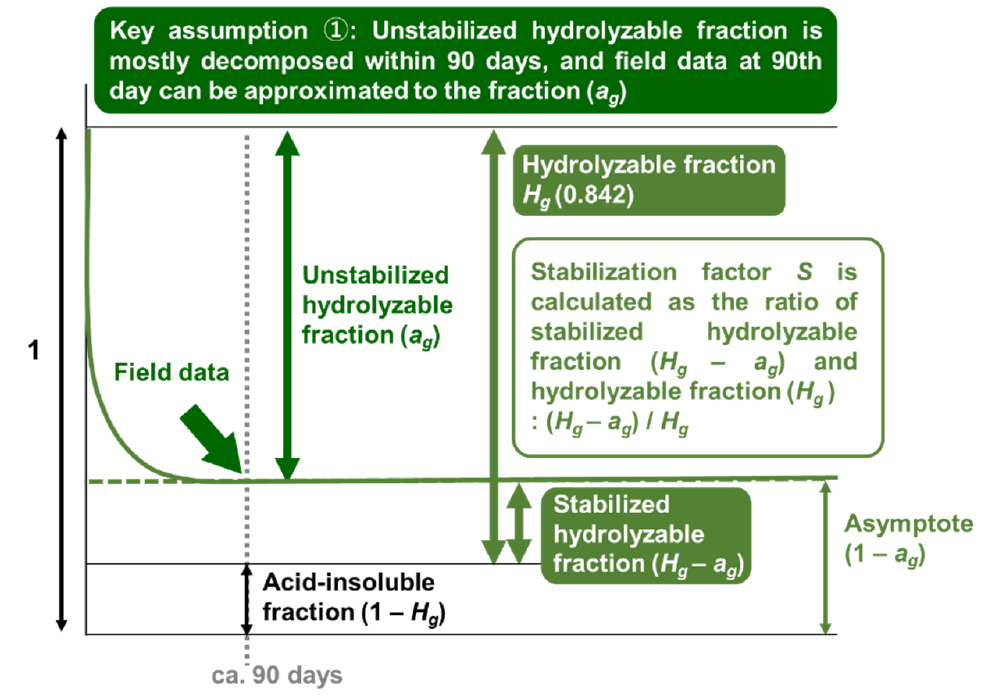
Figure 1. The first key assumption of the Tea Bag Index (TBI) approach and how to determine the stabilization factor S . It is assumed that the unstabilized hydrolyzable fraction ( a g ) is mostly decomposed within 90 days, unless the environment is unfavorable for decomposition, and the field data at day 90 can be approximated to the fraction. The figure is modified from Mori et al. [13]. The second assumption is that the S of green tea equals that of rooibos tea, i.e., the stabilized hydrolyzable fraction of rooibos tea ( H r − a r , Figure 2) can be determined by multiplying S by the total hydrolyzable fraction of rooibos tea ( H r , Figure 2), as